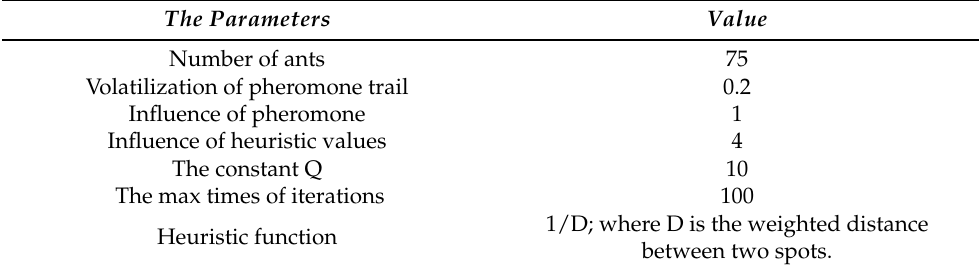
Table 2. The parameters chosen for the ACO in this work.